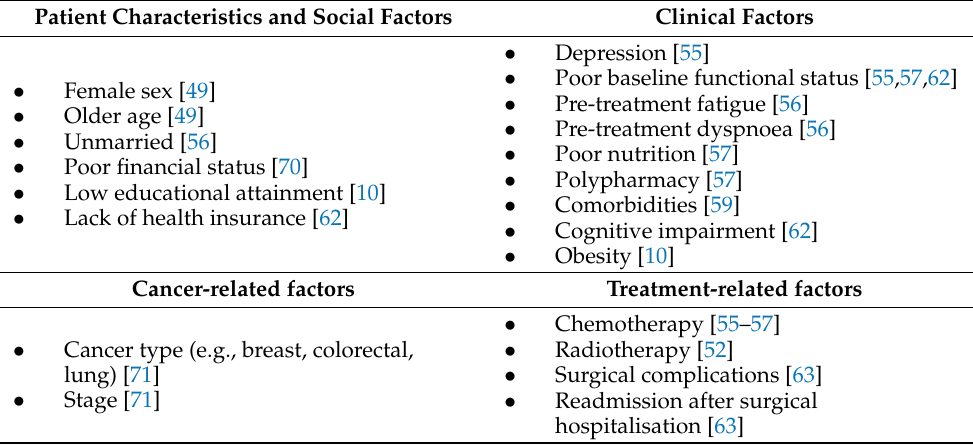
Table 2. Factors that may predict functional decline in older patients with